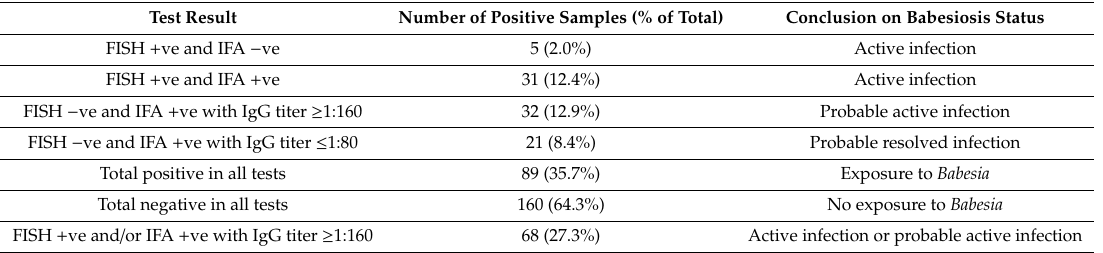
Table 1. USA / Puerto Rico clinical